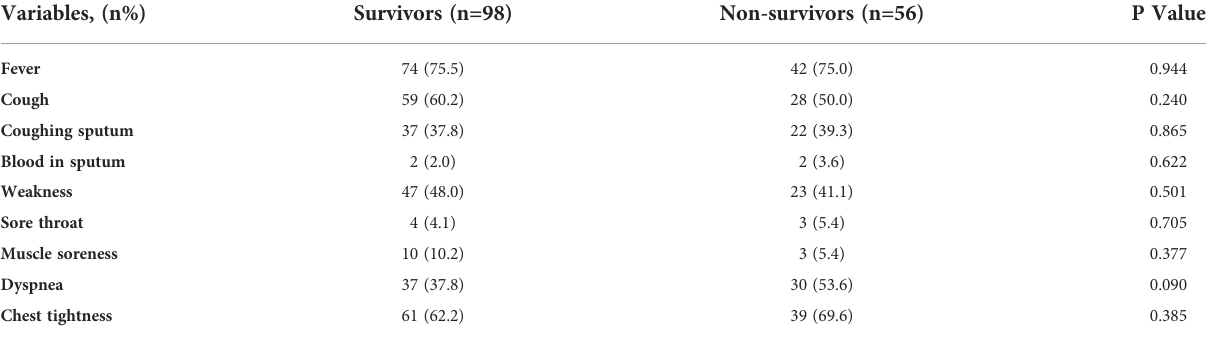
TABLE 2 Comparison of symptoms between the two groups of patients.